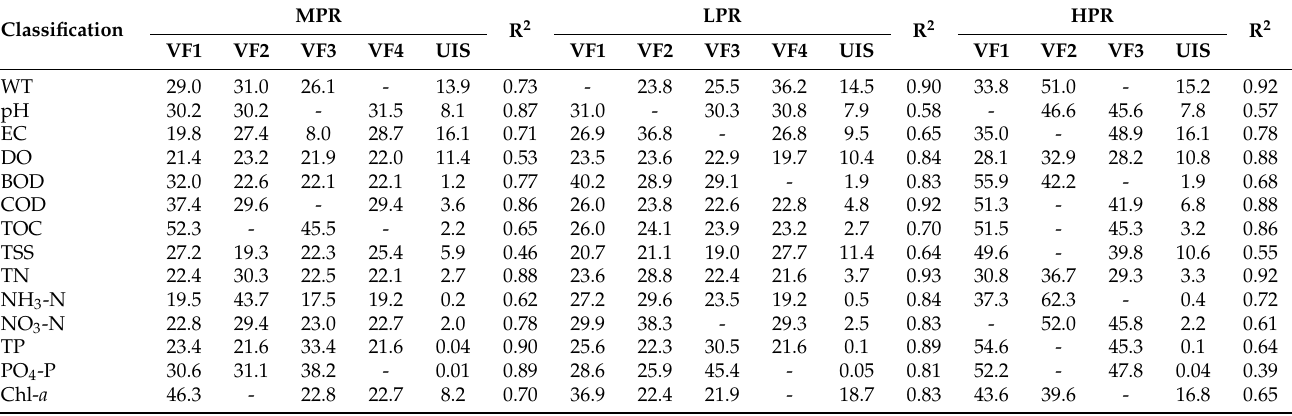
Table 3. Contribution (%) on selected water quality variables of different pollution sources in MPR, LPR, and HPR using APCS-MLR.